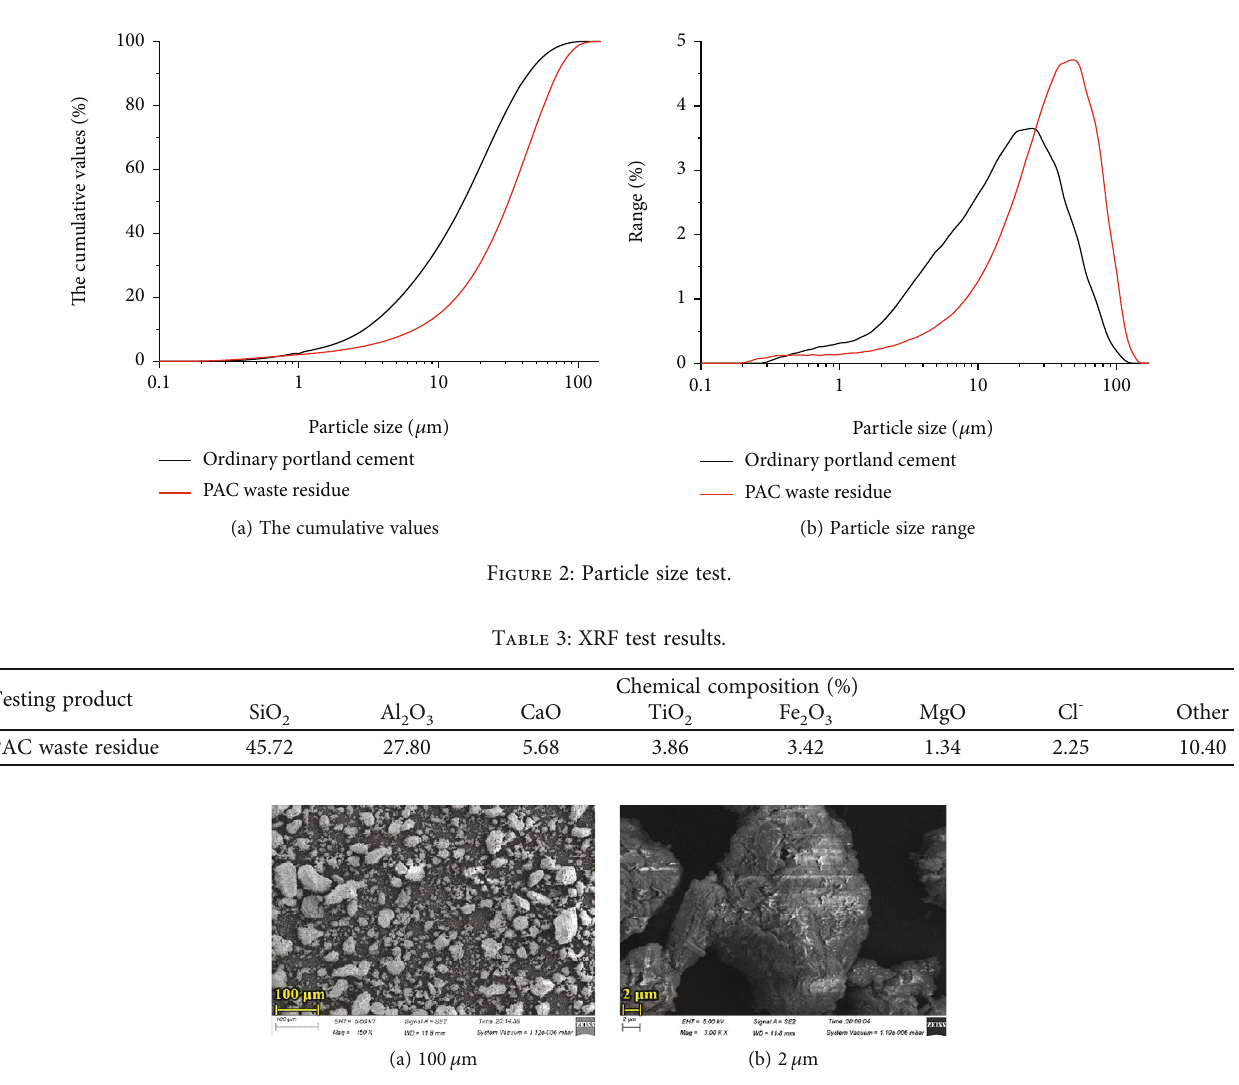
Figure 3: SEM test results of PAC waste residue.